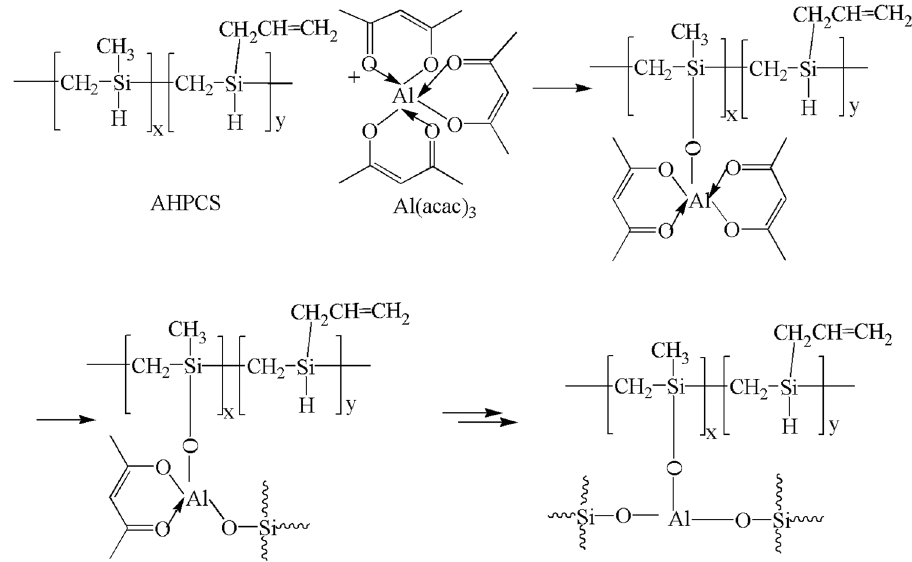
Figure 5: Reaction mechanism between AHPCS and Al ( acac ) 3 .